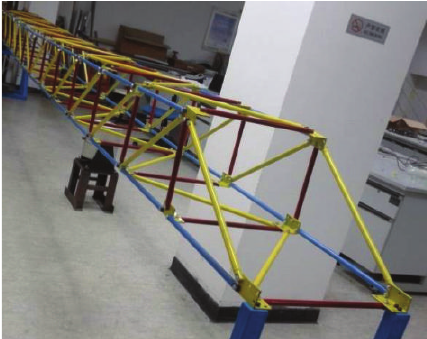
Figure 19: Test truss structure.